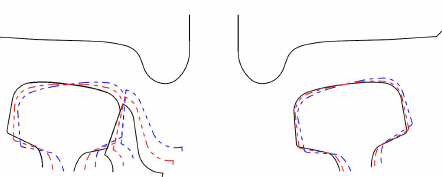
Figure 7. Rail cant adjustment of a typical cross-section (the angle is 5 times enlarged for illustra- tion).